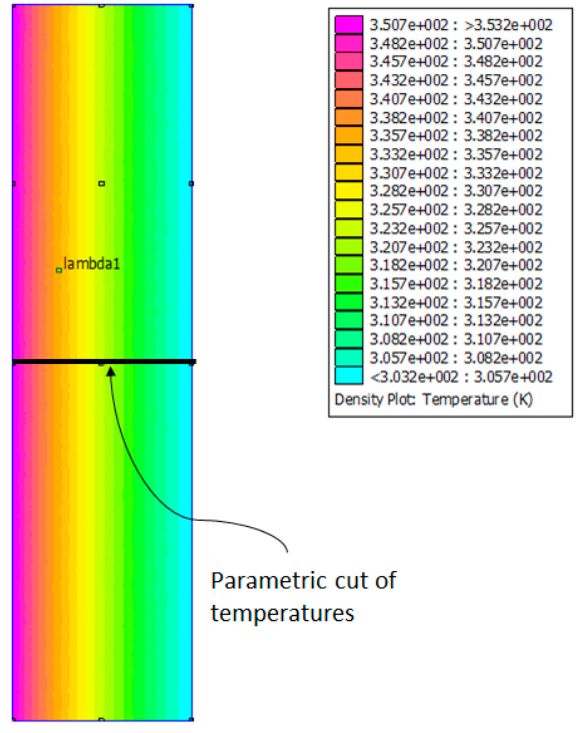
Figure 3. Temperature distribution in a section of a tube.